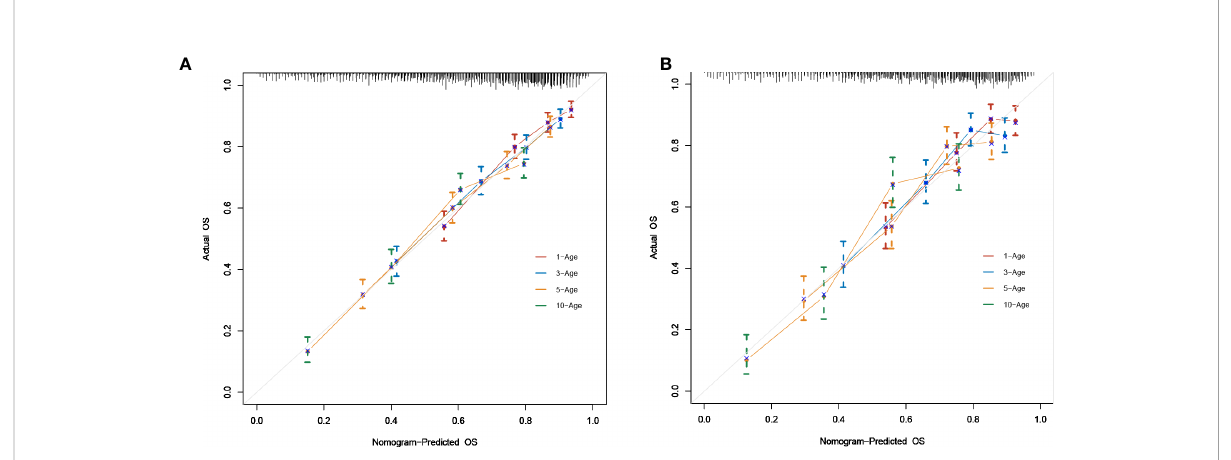
FIGURE 4 The 1,3,5,10-year Calibration curves for training (A) and validation (B)